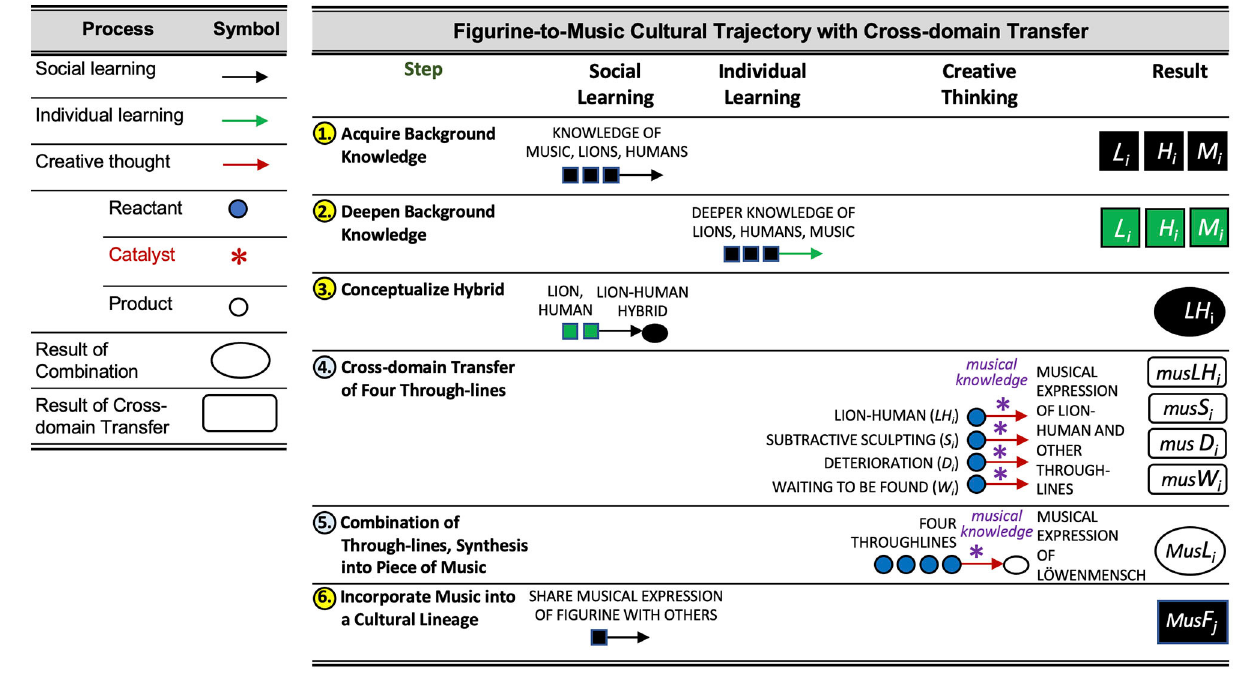
FIGURE 2 | (Left) Processes involved, and symbols used to depict them. (Right) Cognitive steps culminating in the cultural lineage described in the text. Items in black are transmitted through social learning. Items in green are the result of individual learning. Each instance of social learning (Column 2) has been preceded by some individual at some point in the lineage by a relevant instance of individual learning (Column 3) or creative thinking (Column 4). Steps one, three, and six transmit foodset (existing) knowledge amongst individuals. Step two occurs through assimilation of the environment not mediated by social learning. Steps four and five generate new foodset-derived knowledge in the mind of the